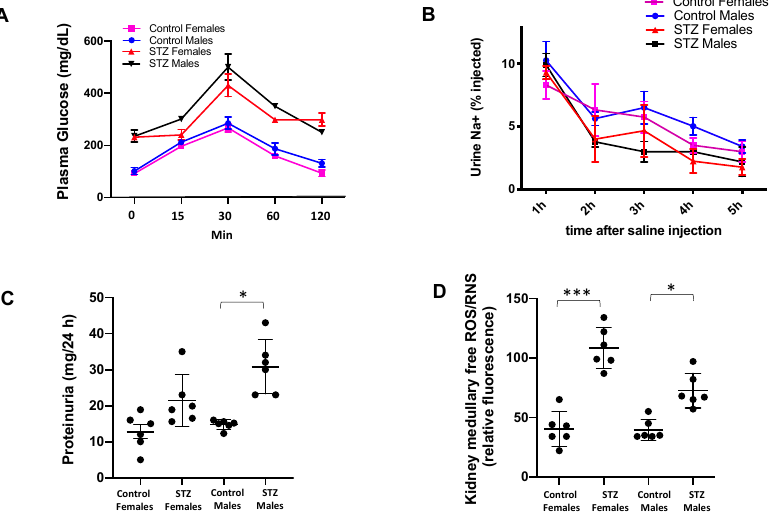
Figure 2. Plasma glucose, Na + retention after saline challenge, proteinuria, and kidney ROS in male and female control and STZ mice. ( A ) Phenotype of type 1 diabetes mellitus was confirmed by a tolerance glucose test at day 5. STZ mice were not able to recover basal levels of FBG when compared to control animals. ( B ) Control and STZ mice were injected with isotonic saline (i.p. 10% of body weight) and in placed metabolic cages for Na + urine measurements. STZ treatment caused Na + retention in STZ males and females when compared to control group. ( C ) Proteinuria was significantly increased in STZ males but not in STZ female mice relative to their counterparts. ( D ) Kidney homogenates were used to measure free ROS/RNS levels; these were augmented in the female (*** p < 0.001) and male (* p < 0.05) STZ groups. 3.2. Expression of TGF- β 1, Fibronectin and NOX-4 in Renal Medullary Tissues from Male and Female Mice after 6 Days of Streptozotocin (STZ)-Induced Type 1 Diabetes After 6 days of STZ administration, NOX-4 mRNA/ β -actin mRNA ratio was aug- mented in female STZ mice when compared to control female mice (39.2 ± 5.1 vs. control 2.5 ± 0.7, p < 0.001); this increase was not observed in male STZ mice (Figure 3A). Fi- bronectin mRNA/ β -actin mRNA ratios were augmented in female (8.7 ± 0.6 vs. control 2.8 ± 0.6 p < 0.01) and male STZ mice (5.3 ± 0.4 vs. control 1.6 ± 0.5 p < 0.05, Figure 3B). Similarly, TGF- β 1 mRNA/ β -actin mRNA ratios were significantly augmented in STZ fe- males vs. control female mice (3.2 ± 0.2 vs. control 0.8 ± 0.1, p < 0.05), and male STZ mice (2.0 ± 0.2 vs. control 0.9 ± 0.1, p < 0.05, Figure